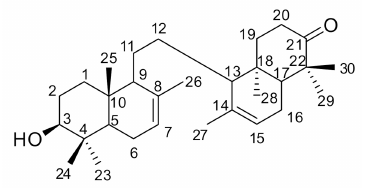
Figure 1. Chemical Structure of compound 1